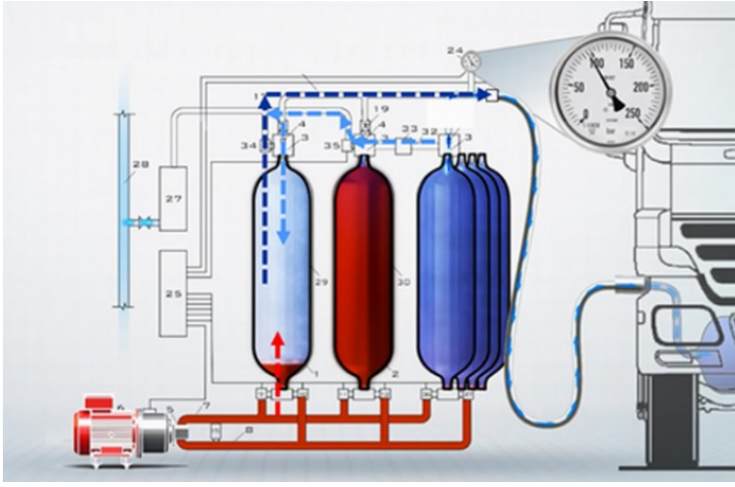
Fig. 3. Hydraulic piston operating in a boosting